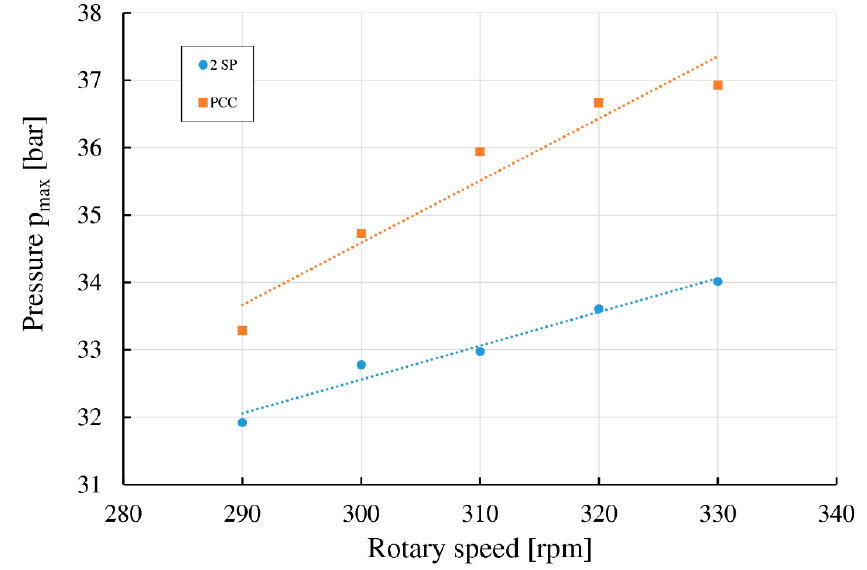
Figure 11. Peak of pressure for GMVH-12 engine with SP and PCC ignition arrangements.